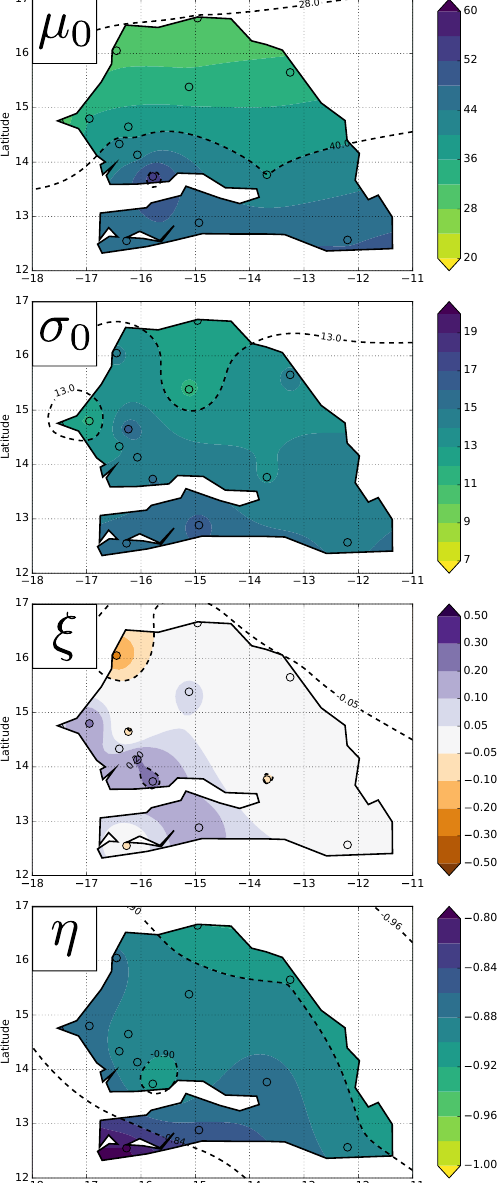
Figure 10. Maps of IDF SiSca parameters: µ 0 [mmh − 1 ], σ 0 [mmh − 1 ], ξ [–], and η [–].